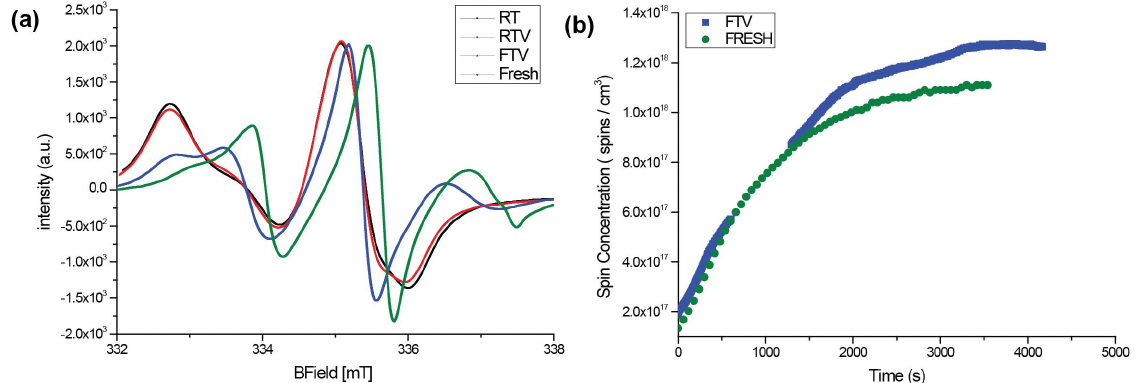
Figure 5. ( a ) EPR spectra of TEMPOpp RT, RTV and FTV on NaCl after 10 weeks ( b ) Time evolution of spin concentration upon exposure to air of 15-week-old TEMPOpp FTV vs. fresh